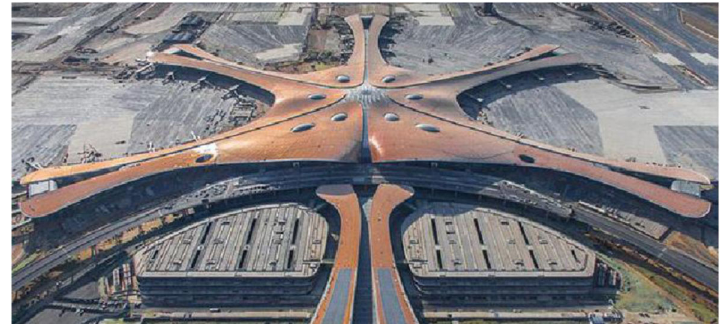
Fig. 12 Beijing Daxing International